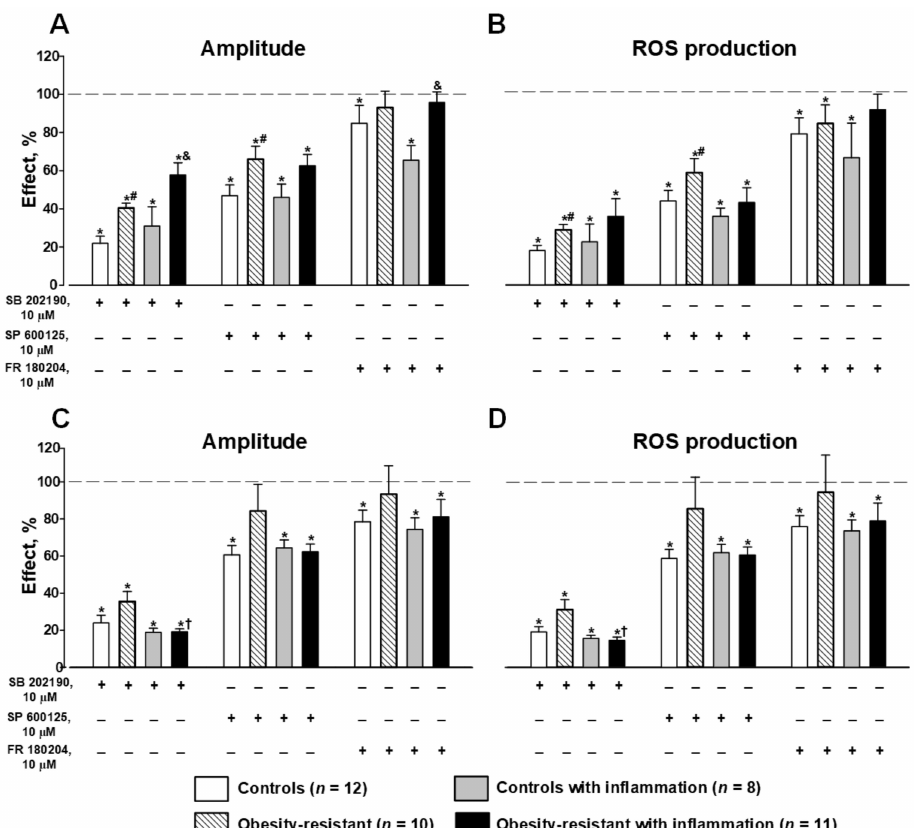
Figure 5. The effects of inhibitors of MAP kinases on FPR-mediated respiratory response in murine bone marrow granulocytes. Amplitude and production of reactive oxygen species (ROS) in responses to 1 µ M fMLF ( A , B ) and 1 µ M WKYMVM ( C , D ). Data are presented as mean ± SEM. Significant differences of parameters by Mann–Whitney rank sum test are indicated as follows: * p < 0.05 between inhibitor-treated and intact cells within the same group; by ANOVA on ranks: # p < 0.05 compared to controls; and & p < 0.05 compared to controls with inflammation; † p < 0.05 compared to obesity-resistant